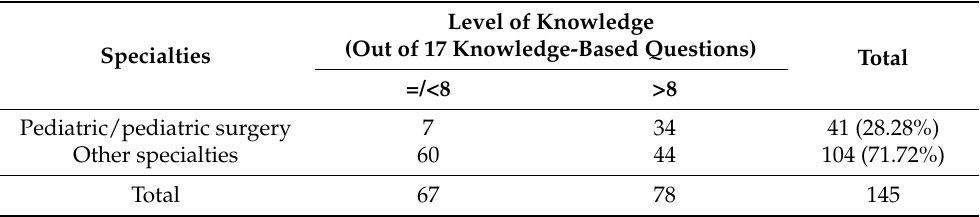
Table 7. Comparison of knowledge levels between pediatric and pediatric surgery respondents and other specialties.